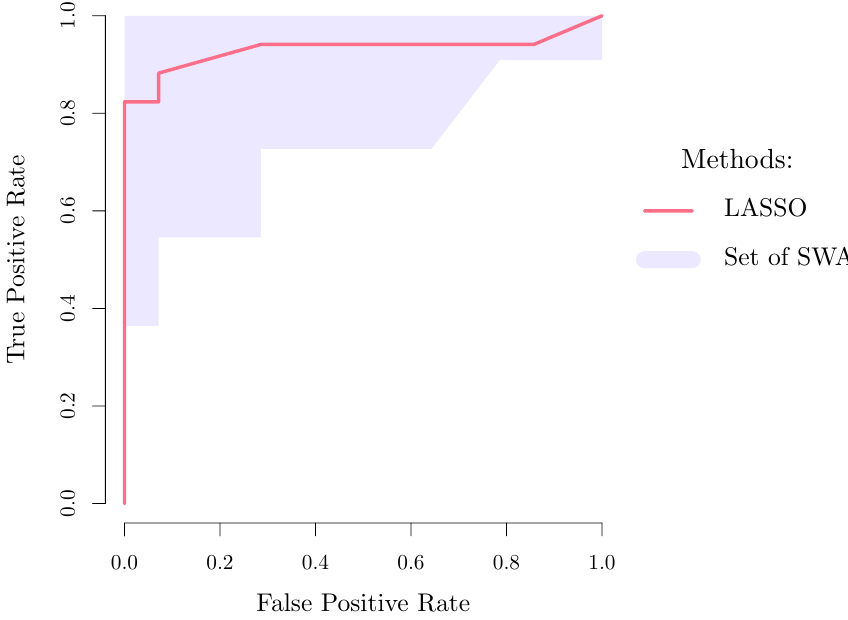
Figure 4. ROC curve comparison between lasso and SWAG . We present the ROC curve of lasso (in red) with the ROC region (in gray) produced by the 112 SWAG models. We obtain the ROC region for the set of SWAG models considering first all the 112 individual model ROC curves and then coloring in gray the area which encloses all the 112 ROC curves at the same time.